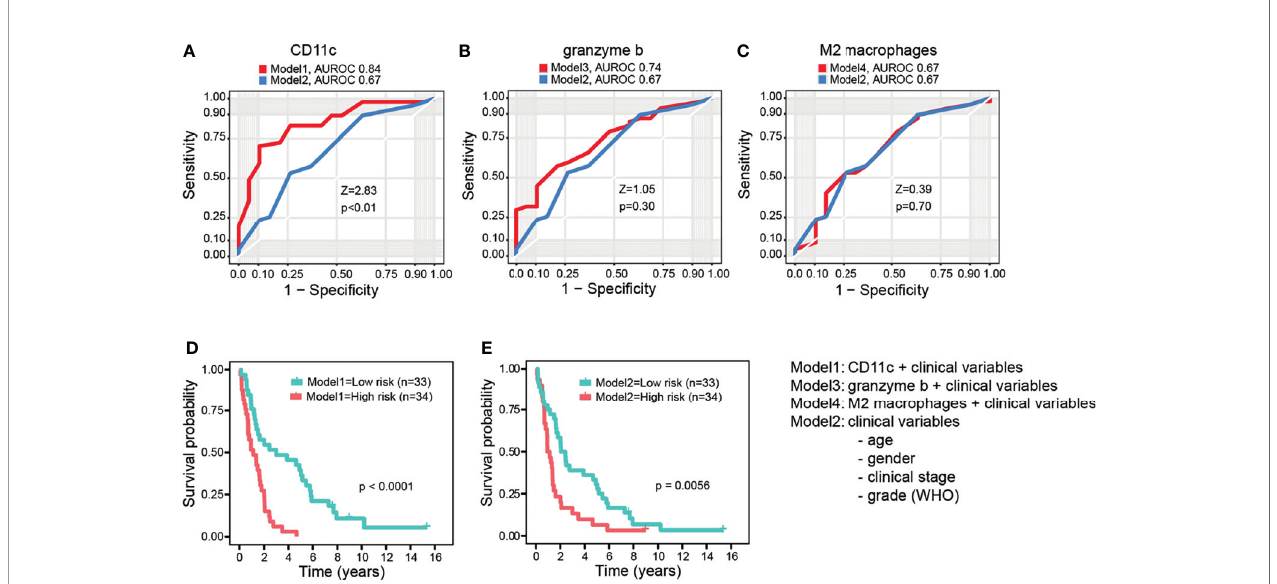
FIGURE 3 | Survival prediction power of combination models. (A) Area under the receiver operating characteristic curves (AUROC) for combined clinical factors (age, gender, clinical stage, and grade) (Model2) and for clinical factors plus CD11c (median dichotomized) (Model1). (B, C) Same as in (A) , but now granzyme B and M2 macrophages in Models 3 and 4, respectively. The DeLong ’ s test for two correlated ROC curves. (D, E) Kaplan – Meier curves for low- and high-risk dichotomized patient groups with and without CD11c in the model, respectively. Log rank